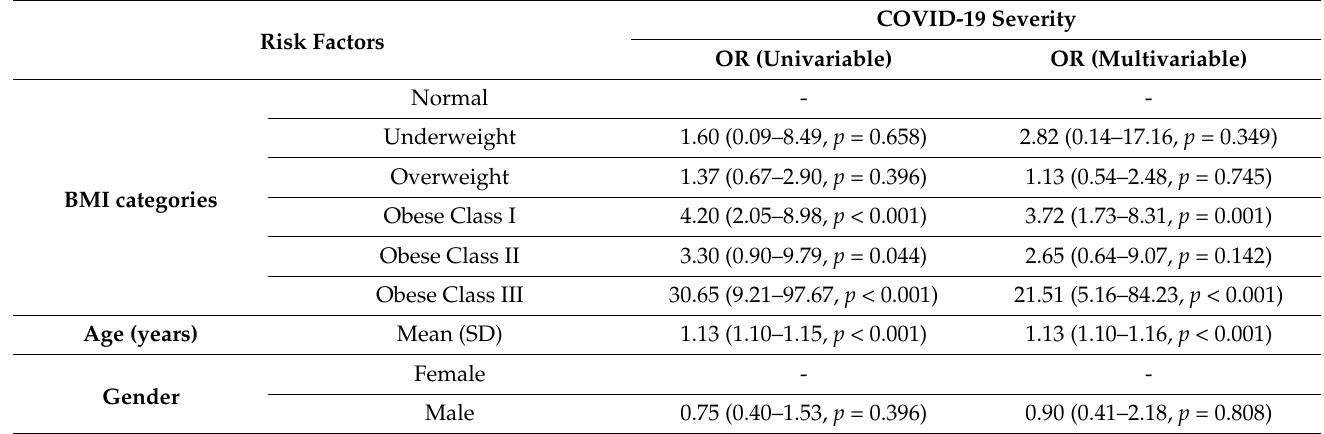
Table 2. Logistic regression analysis of the association between BMI and COVID-19